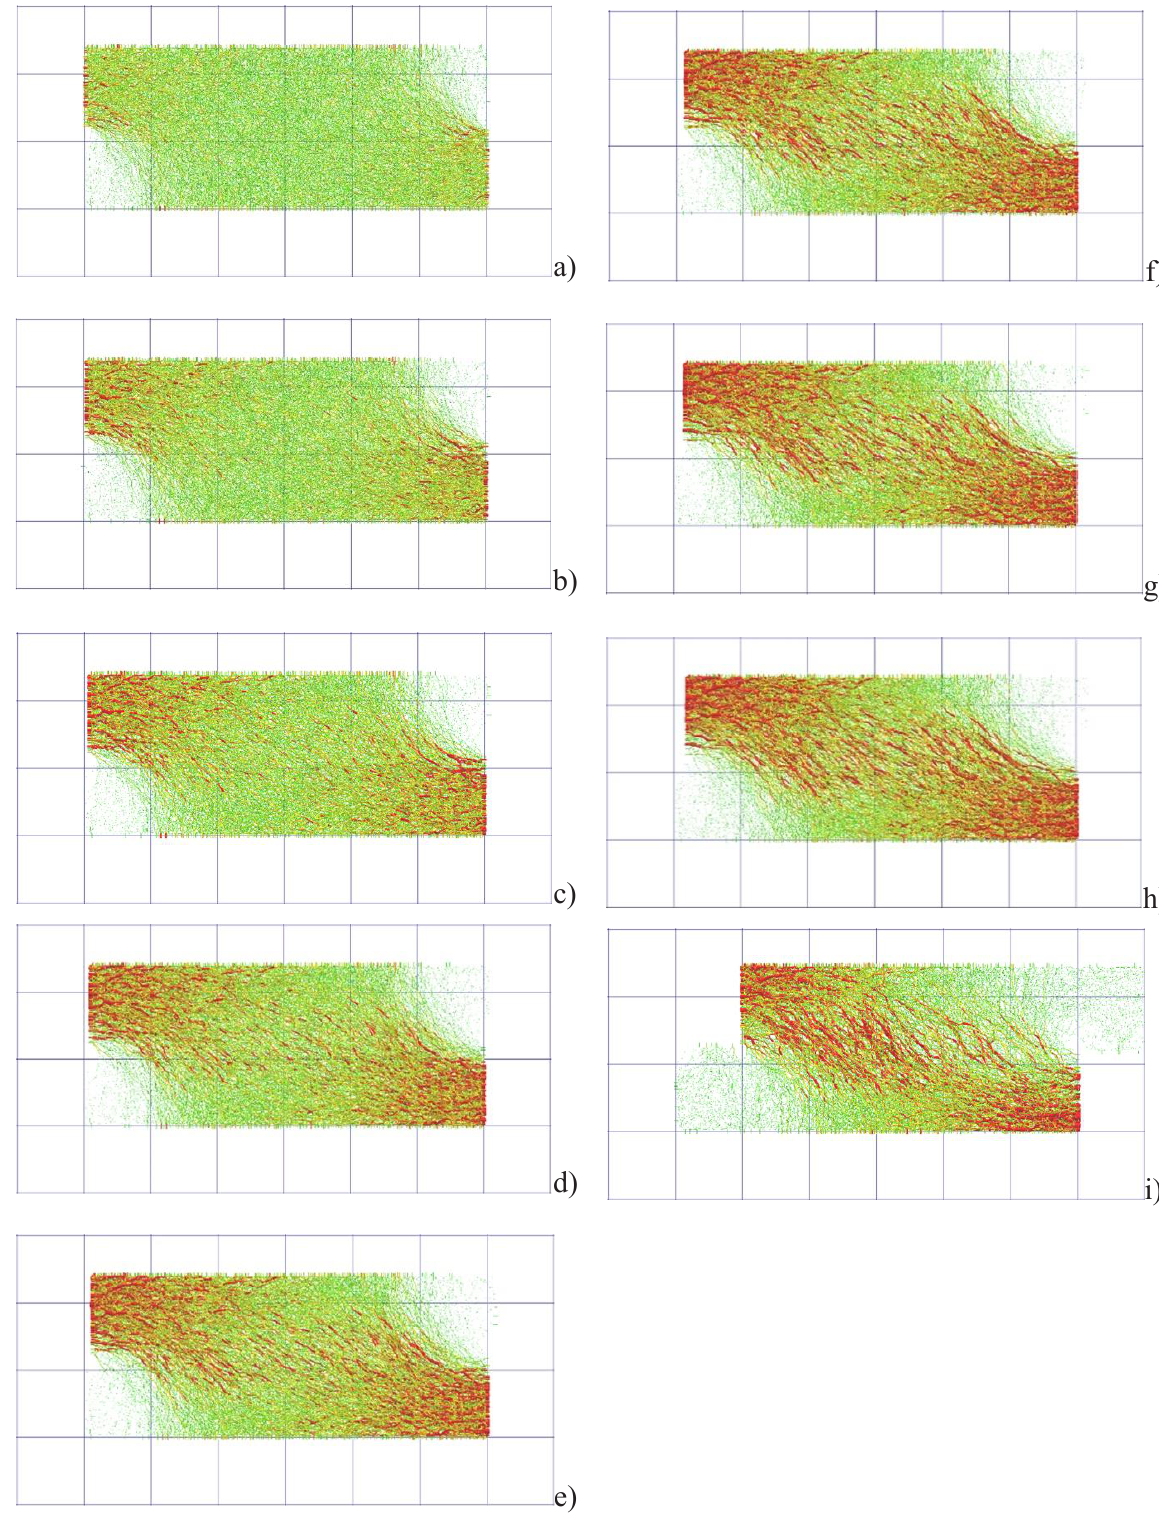
= 0.25 mm, b) u = 0.50 mm, c) u = 0.75 mm, d) u x x x = 10.00 mm ( e = 0.60, σ = 200 kPa, d = 0.5 mm) (red colour corresponds x 0 0 50